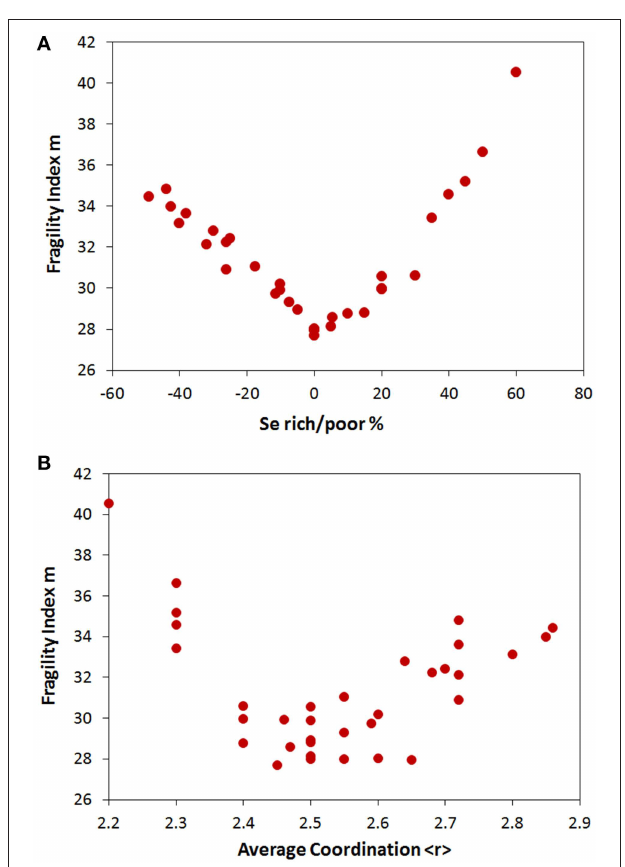
FIGURE 5 | Fragility index m of Ge-As-Se glasses as a function of (A) excess/deficiency of Se in the structure. (B) average coordination < r > .